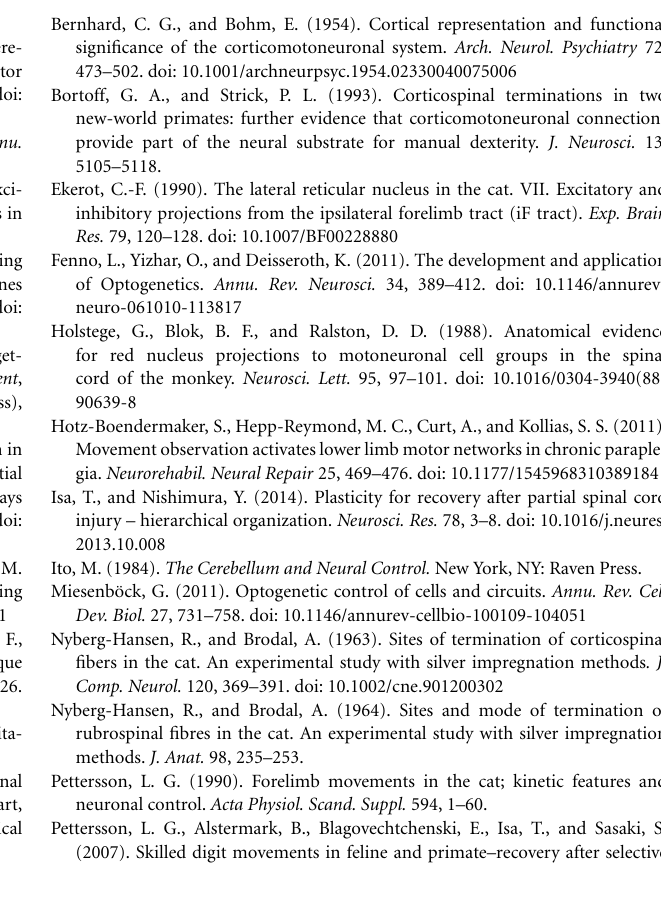
FIGURE 5 | (A) As in Figure 1A but for the Macaque monkey illustrating also the direct (monosynaptic) cortico- and rubromotoneuronal pathways (see text for details). (B) Precision grip movement (video, time